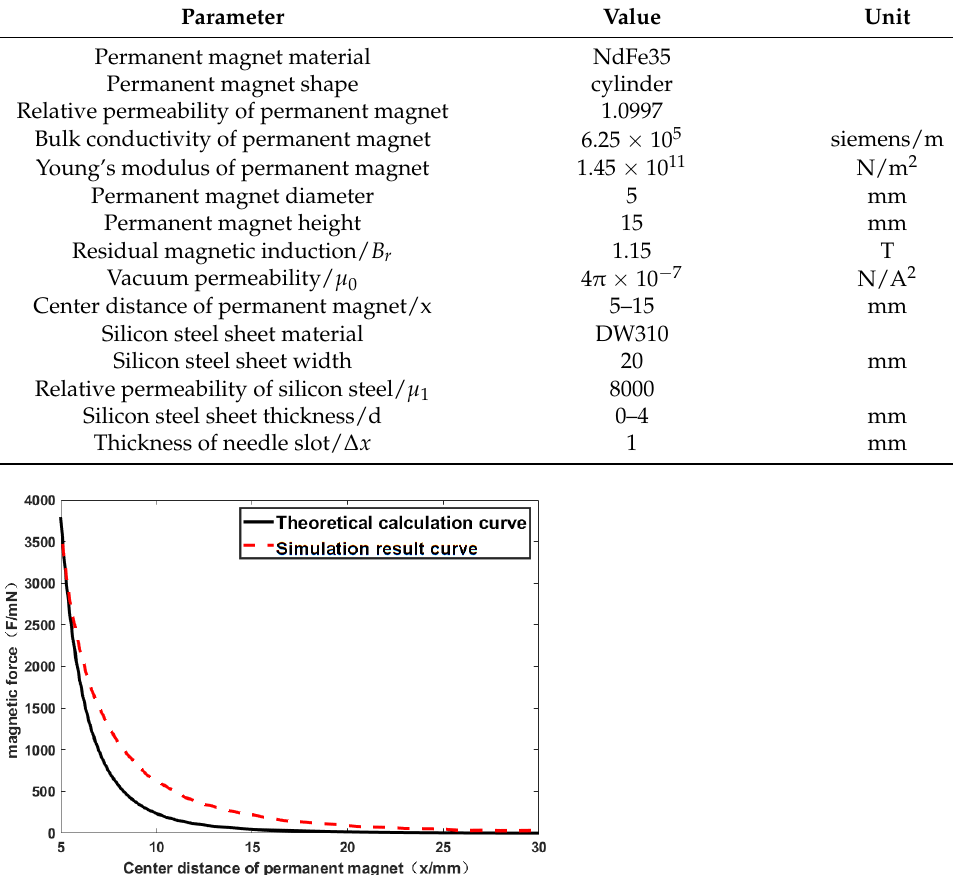
Table 1. Parameters related to permanent magnets and silicon steel sheets.